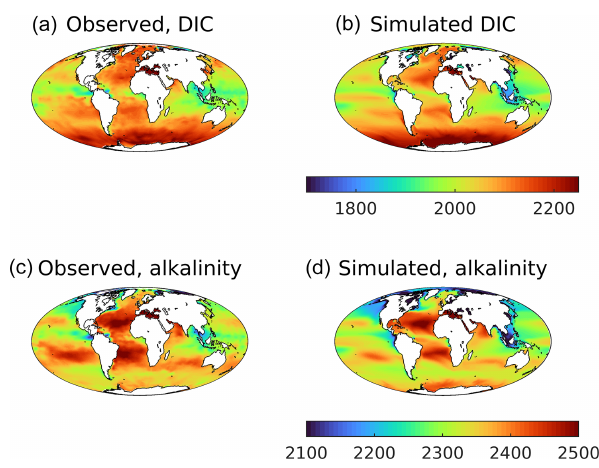
Figure 15. Observational ( a, c ; GLODAPv2) and simulated (b, d) annual average surface dissolved inorganic carbon (a, b) and total alkalinity (c, d) . DIC is given in mmolCm − 3 , and alkalinity is given in meqm − 3 .